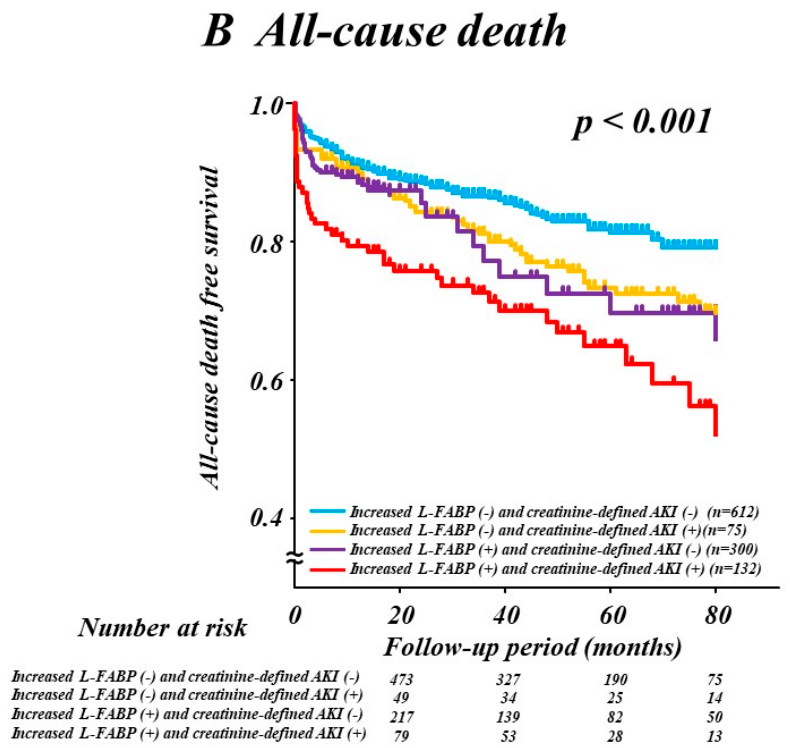
Figure 2. Kaplan–Meier curves for the primary endpoint ( A ) and all-cause mortality ( B ) according to L-FABP increment ( ≥ 9 ng/mL) or serum creatinine-defined AKI status. AKI, acute kidney injury; L-FABP, liver-type fatty-acid-binding protein.